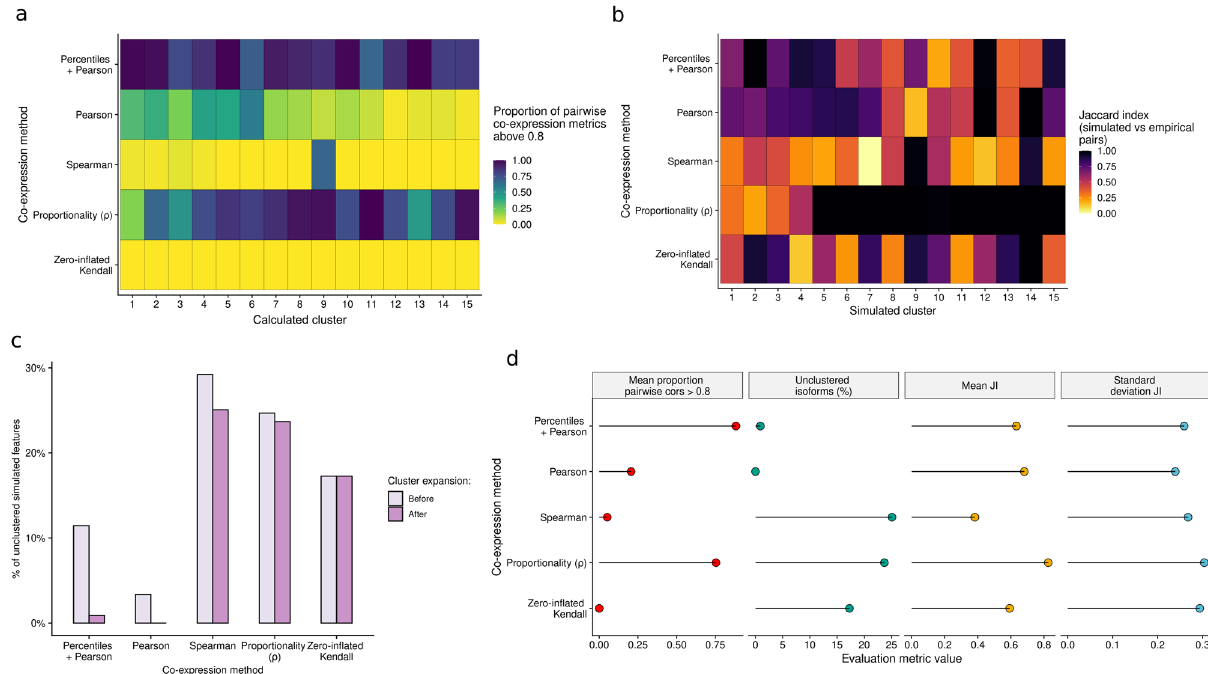
Fig. 3 Comparative evaluation of percentile correlation on simulated clusters. a Proportion of co-expression values above 0.8 in each empirical cluster, obtained after running the acorde clustering pipeline on simulated clusters using several correlation and proportionality methods as a distance metric. b Jaccard index of simulated vs calculated clusters obtained with each evaluated co-expression method. Simulated clusters were paired with one calculated cluster based on mean pro fi le similarity, and synthetic transcripts in each of the paired clusters were compared. c Percentage of unclustered isoforms generated by each co-expression method. Results are shown before and after re-assigning unclustered isoforms by co-expression with the mean pro fi le of extant clusters (i.e., cluster expansion). d Evaluation metric overview. Metrics are speci fi ed in the grid headers. x -axis shows values of the different metrics, y -axis displays evaluated co-expression